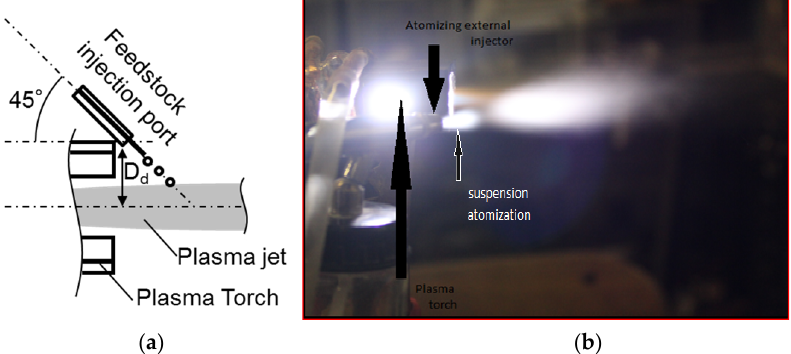
Figure 6. Configuration of the suspension plasma spray torch. ( a ) Illustration of the feedstock injection port; ( b ) Appearance of the plasma jet.